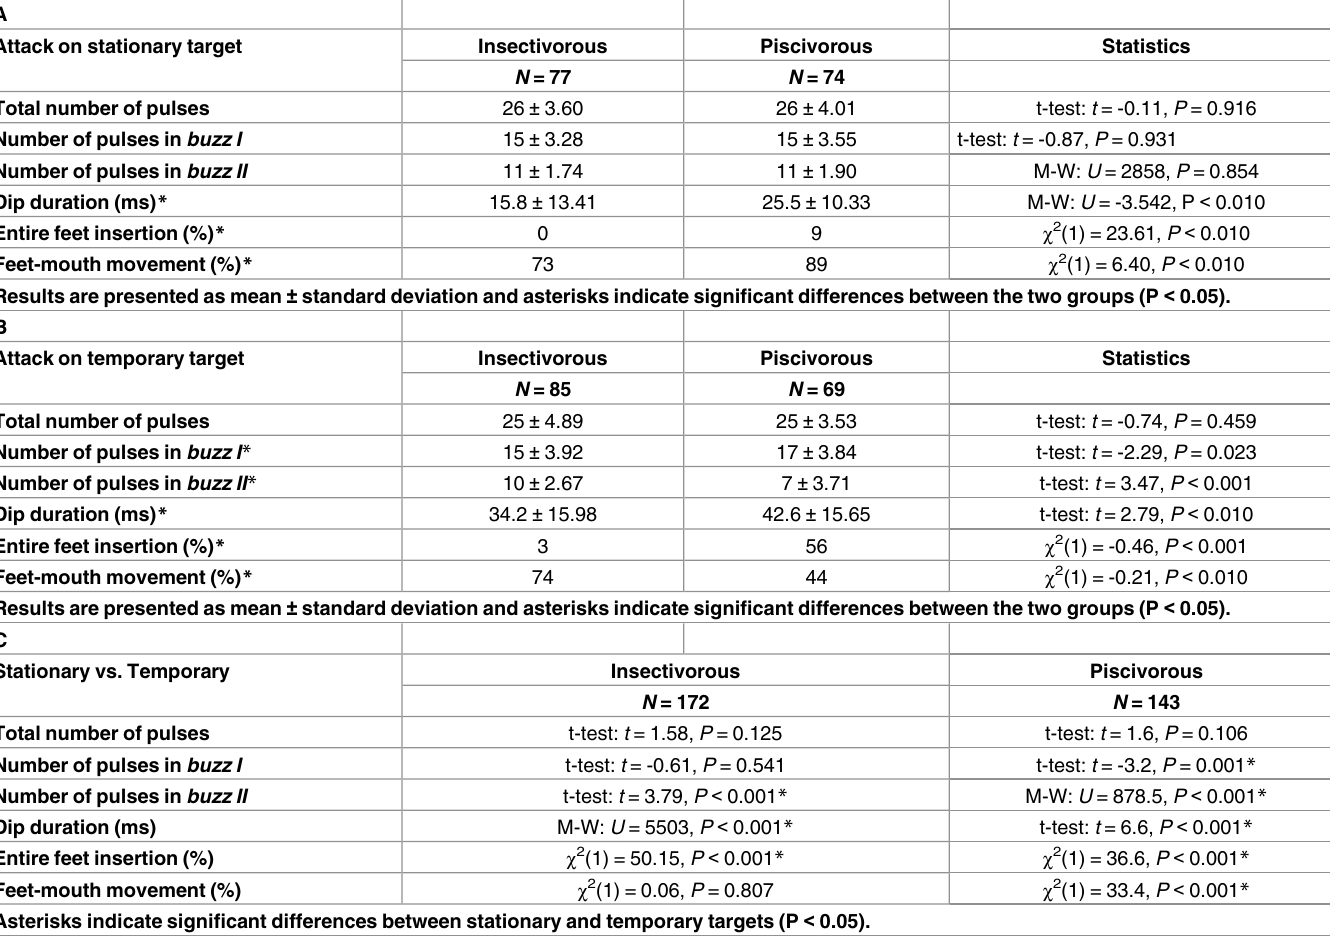
Table 1. General features of the terminal phase and dip pattern measuredduring piscivorous and insectivorous individuals attacks on the station- ary and temporary targets. (A) Differencesin the stationary target attack features betweenpiscivorous and insectivorous individuals( N = 151), (B) differ- ences in the temporary target attack features betweenpiscivorous and insectivorous individuals ( N = 154) and (C) statistical tests betweenstationary and temporary target attack features in each group. Entire feet insertion refers to the relativeproportionof attacks where the entire feet were inserted into the water. The detailedmeasurements of dip depth are shownin the supportinginformation S2 Fig. Feet-mouth movement is a binary measureof whetherbats move or not the head toward the tail membrane/feet after the capture